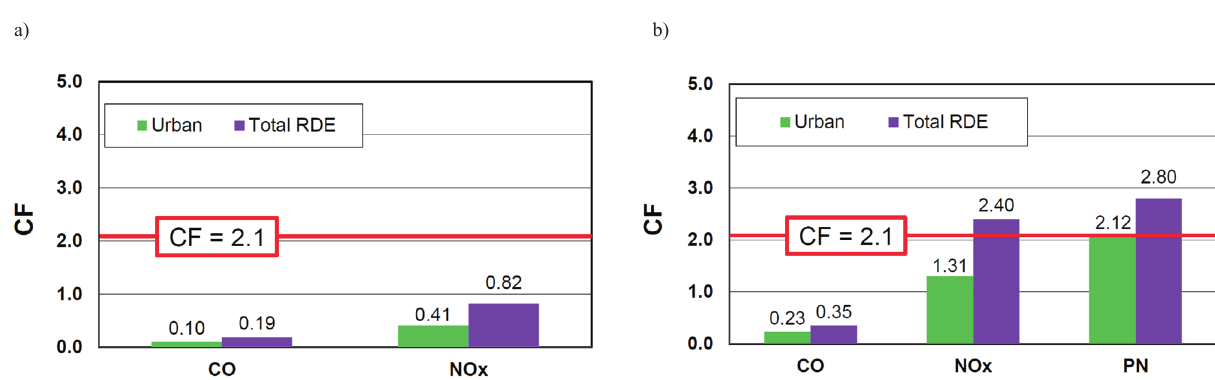
Fig. 12. Conformity factors of carbon monoxide and nitrogen oxides from gasoline vehicle (a) and carbon monoxide, nitrogen oxides and particle number for a diesel vehicle